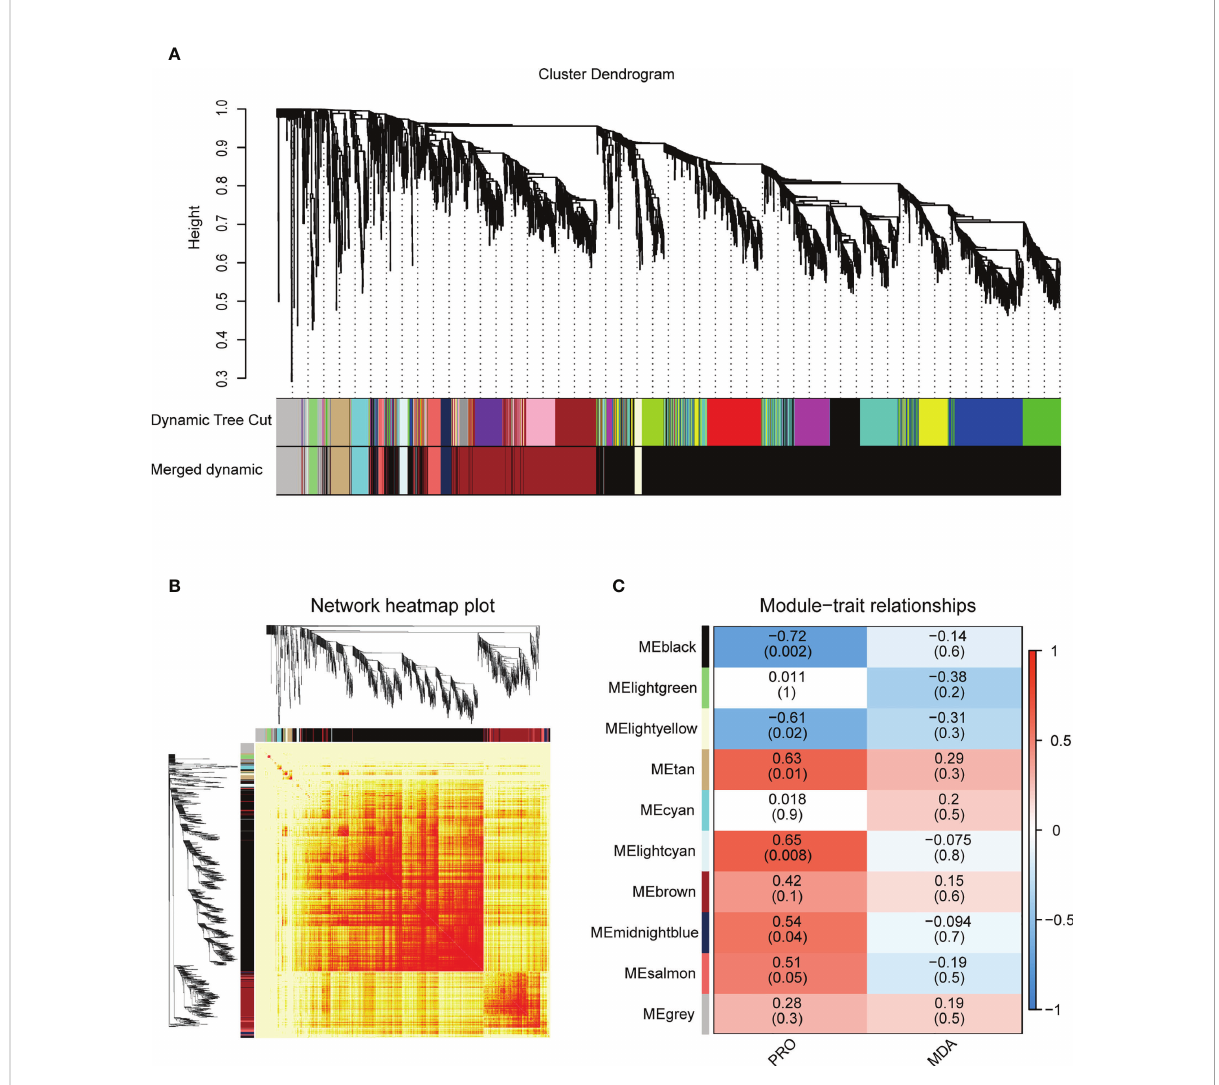
FIGURE 4 Weighted gene co-expression network analysis (WGCNA) of salt stress-responsive genes in the DM plantlets under salt stress. (A) Hierarchical cluster tree of the common genes between different studies. The branches and color bands represent the assigned modules; the tips of the branches represent genes. (B) The heat map shows the Topological Overlap Matrix (TOM) value among the proteins of the network delimited into modules by the dynamic method. Lower TOM is indicated by the yellow color and higher TOM is indicated by the progressively red color. (C) The thermogram showed the correlations between the modules and the contents of proline and malondialdehyde. No signi fi cant correlations are displayed in white, positive correlations and negative correlations are displayed in red and blue, respectively. PRO, proline; MDA, malondialdehyde (the same